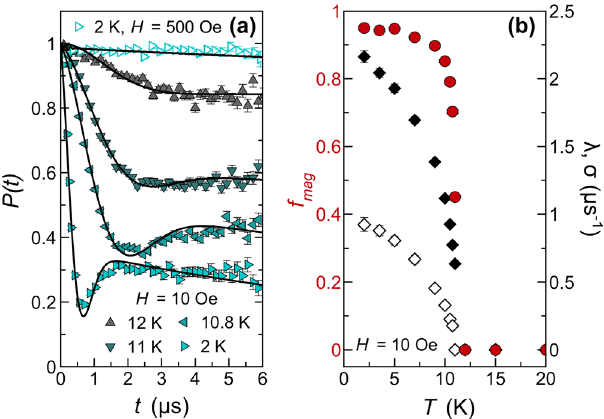
Fig. 2 Bulk magnetism in Ti 3 Cu 4 from muon spin relaxation. a Representative muon decay asymmetry for Ti 3 Cu 4 in an applied magnetic fi eld H = 10 Oe for various temperatures ( fi lled triangles) as well as at T = 2 K and H = 500 Oe (open triangles) with fi ts to Eqn. 1 (solid lines), showing the onset of static magnetic order. b The temperature dependence of the fi t parameters: the magnetic volume fraction, f mag (red circles, left axis), and the Gaussian, σ ( fi lled diamonds), and Lorentzian, λ (open diamonds), relaxation rates. Error bars, where indicated, represent one standard